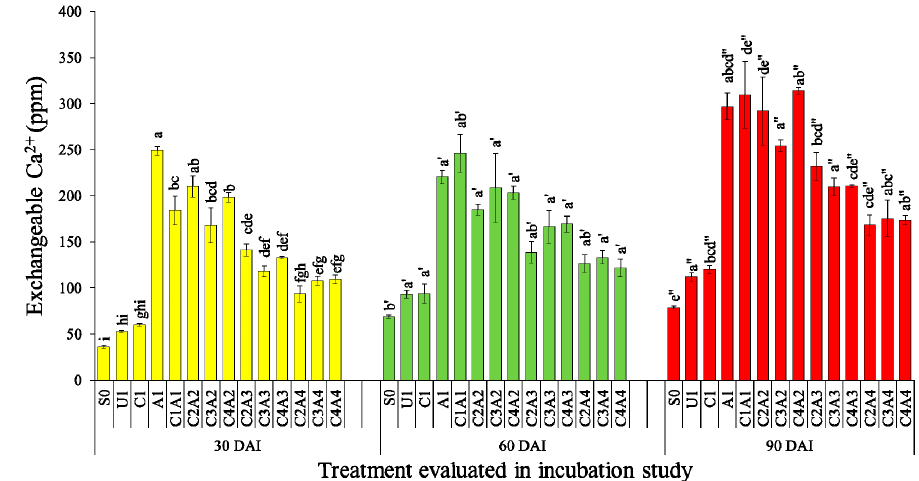
Figure 10. Treatments on soil exchangeable calcium ions after thirty, sixty, and ninety days of incubation. Means with different letter(s) within the same incubation period indicate significant difference between treatments by Tukey’s HSD test at p ≤ 0.05. Bars represent the mean values ± SE.